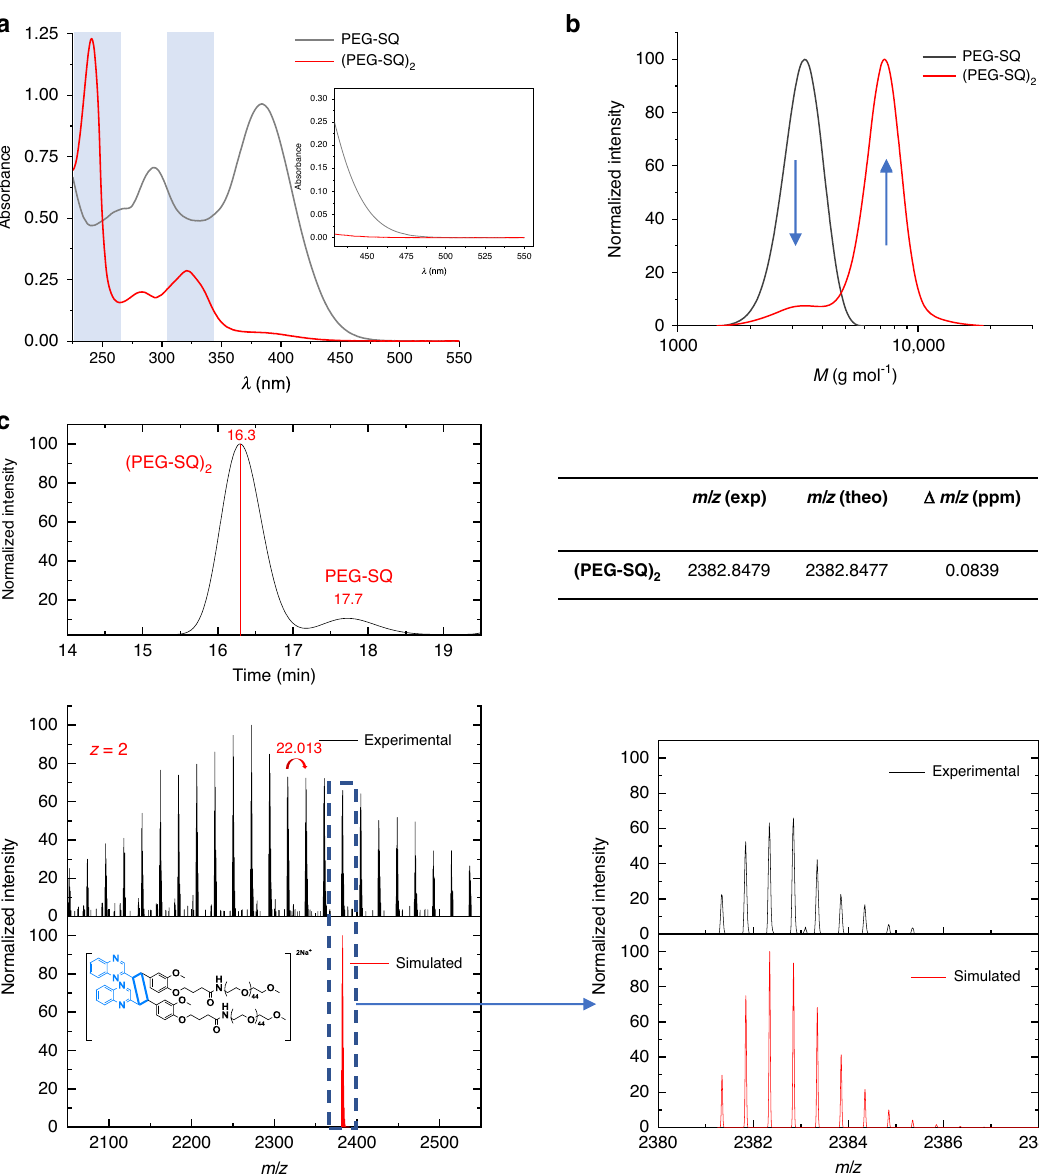
Fig. 2 Characterization of the cycloaddition product. a UV/vis spectra of PEG-SQ and (PEG-SQ) 2 dimer after irradiation at 510 nm with 9.29 × 10 22 photons in water (10 mg mL − 1 ), with the gray bars showing the appearance of new absorption peaks speci fi c to quinoxaline due to the change in conjugation after irradiation at 510 nm. The insert shows the expanded absorbance spectra between 450 and 550 nm. b SEC data (calibrated against PMMA) of PEG-SQ and (PEG-SQ )2 after irradiation at 510 nm with 9.29 × 10 22 photons in water (10 mg mL − 1 ). c SEC-MS analysis of cycloaddition of PEG- SQ after irradiation at 510 nm with 9.29 × 10 22 photons. SEC trace of the (PEG-SQ) 2 peak at 16.3 min jointly with the PEG-SQ peak at 17.7 min. High resolution MS spectrum displaying doubly charged species of the (PEG-SQ) 2 peak after 16.3 min of elution in the SEC trace. The m /z difference between patterns is 22.013, corresponding to half of one PEG repeating unit. Zoom into the MS spectra of experimental and simulated isotopic patterns, indicating their excellent agreement. The inset table shows the theoretical and experimental m / z values of the (PEG-SQ )2